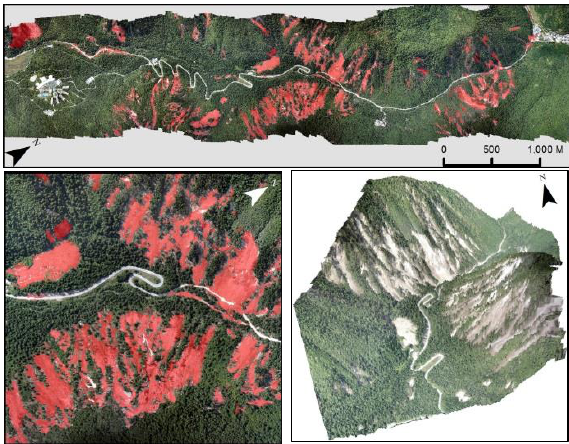
Figure 5. Automatic extraction result of earthquake